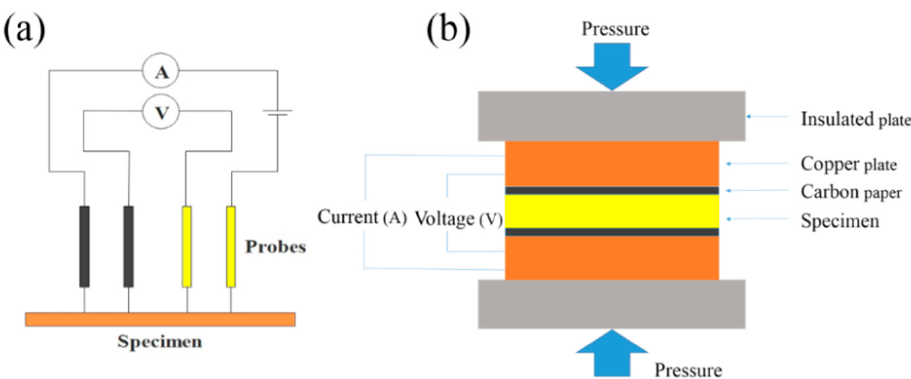
Figure 2. Principle of four-probe resistance test on coating layer and interface contact resistance, ( a ) schematic diagram of four-probe resistance test; ( b ) schematic diagram of interface contact resistance test (ICR).